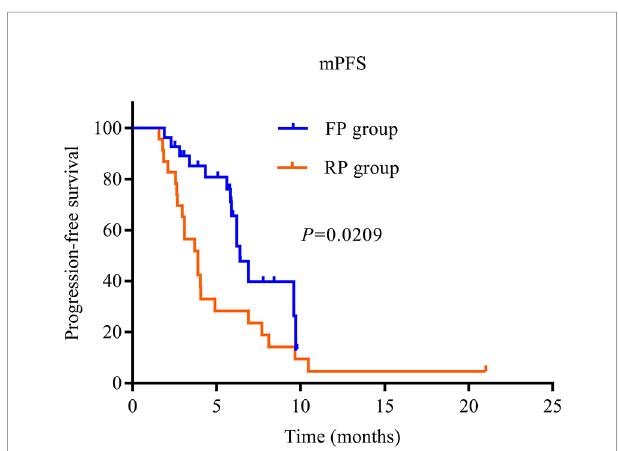
FIGURE 2 | Kaplan – Meier curves of median progression-free survival of patients in the two groups. PD-1, programmed death receptor-1; FP, fruquintinib combined with PD-1 inhibitors; RP, regorafenib combined with PD-1 inhibitors; PFS, progression-free